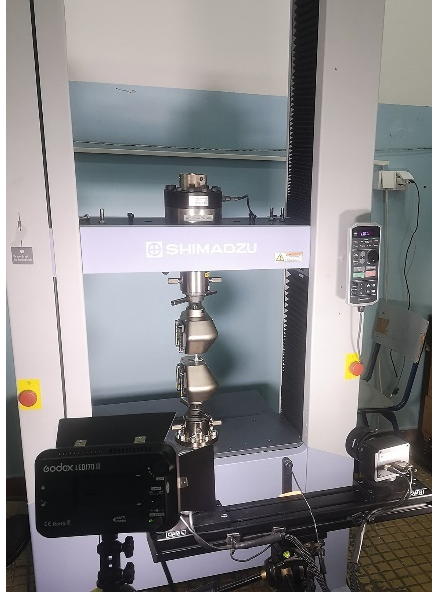
Figure 3. Experiment setup for tensile testing using 3D DIC.